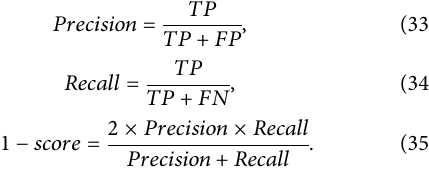
TABLE 2 Details of the experimental environment.